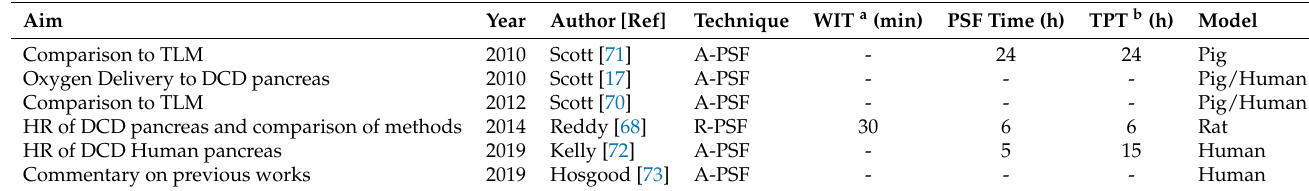
Table 3. Recent Persufflation work on the